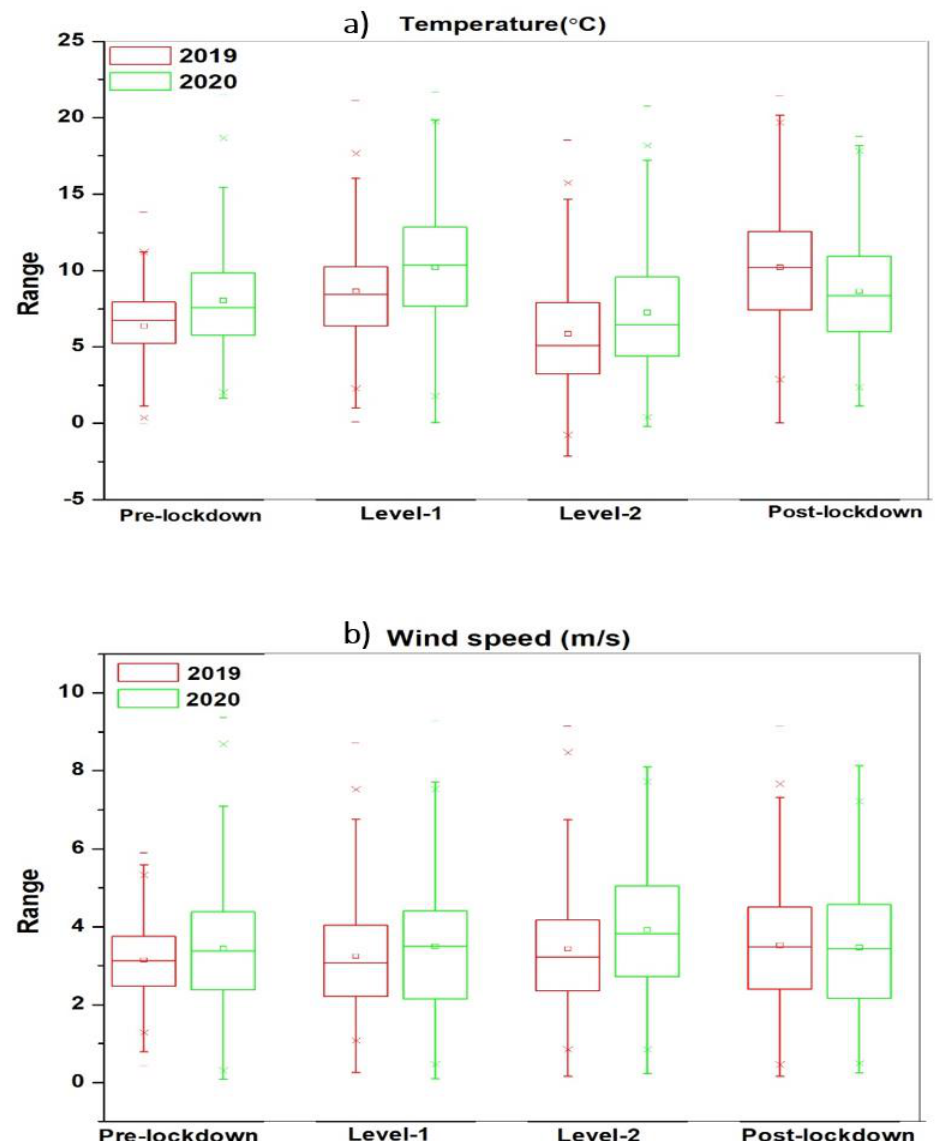
Figure 5. The boxplot categorized into four levels of the study period for ( a ) temperature (°C) and ( b ) windspeed (m/s) attained from ERA5.